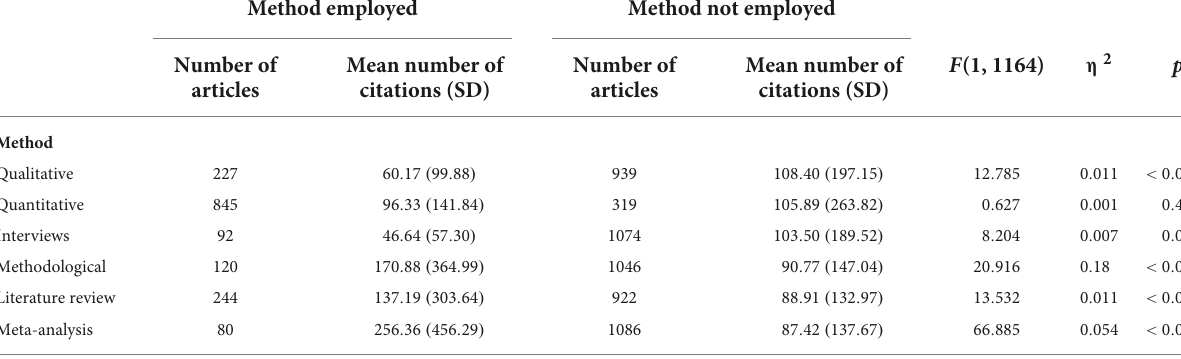
TABLE 4 Mean number of citations across employed